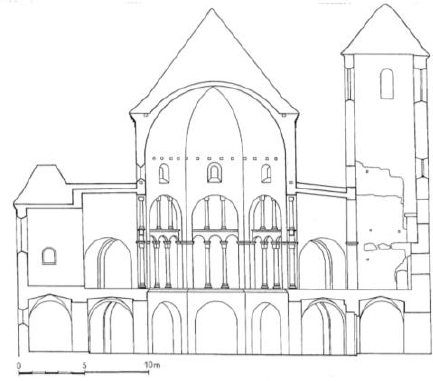
Figure 4. Sectional view created by hand in